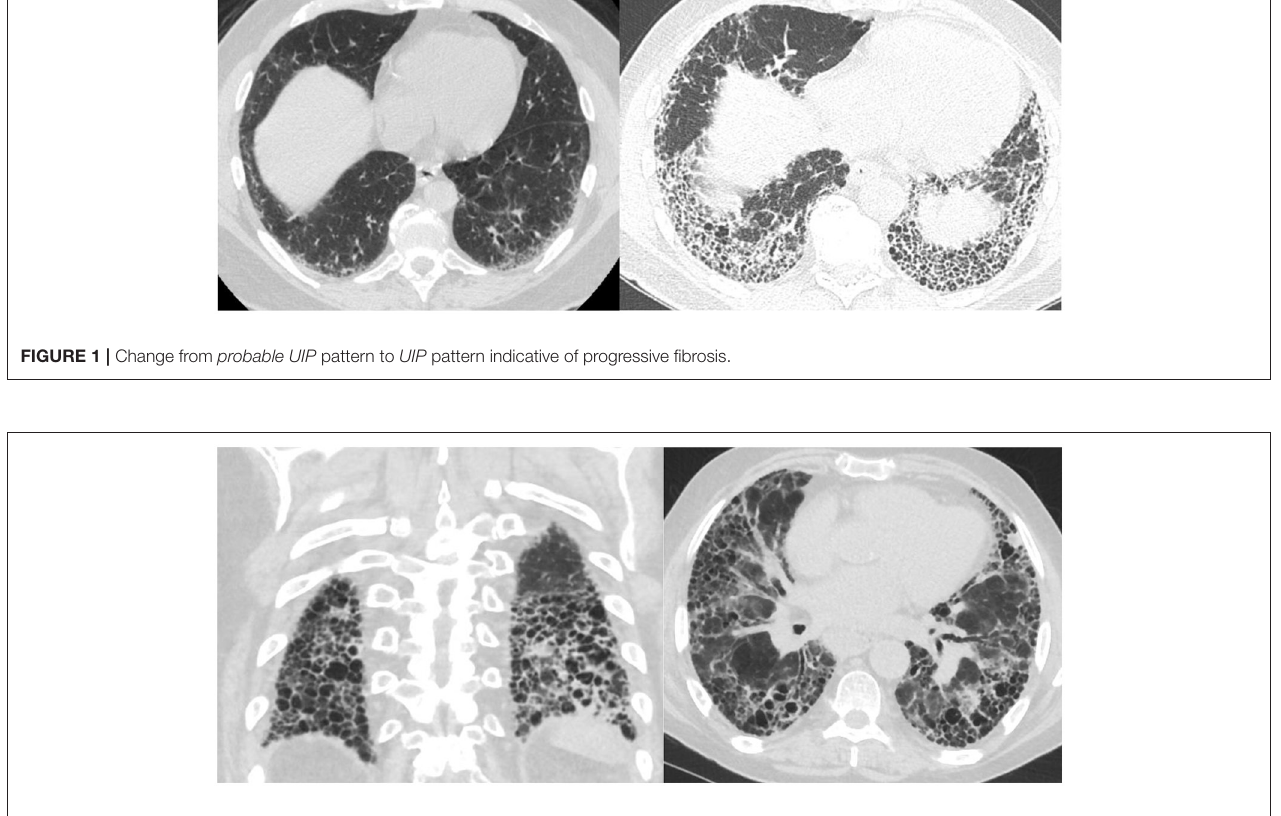
FIGURE 2 | Axial and coronal images with straight edge sign characteristic of a UIP pattern associated with